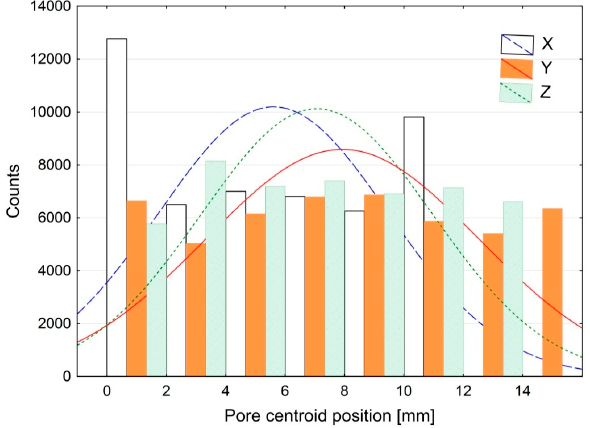
Figure 5. Histogram of the coordinate distribution describing the location of pores in the adhesive modified with 0.50% of the modifier (lyophilized fungal preparation).